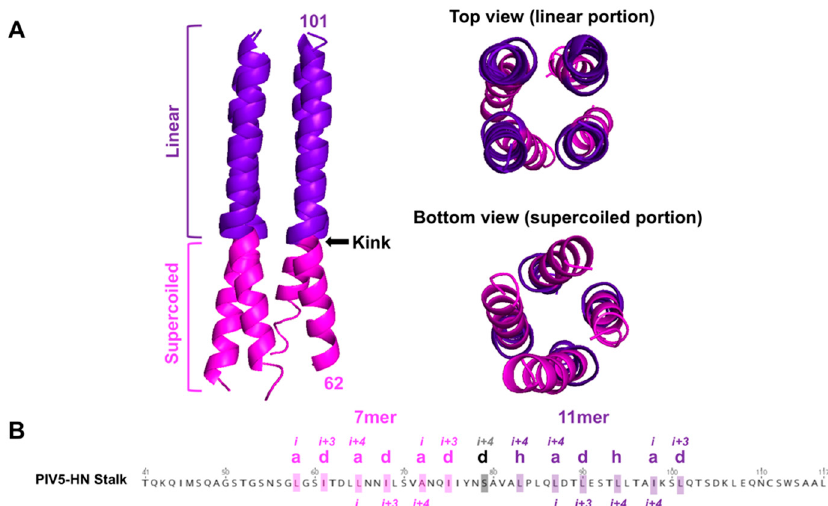
Figure 5. The tetrameric 4HB stalk exhibits transition from a supercoiled 7mer repeat lower region to a non-supercoiled, linear 11mer repeat upper region. ( A ) left, a side view of the PIV5-HN 4HB